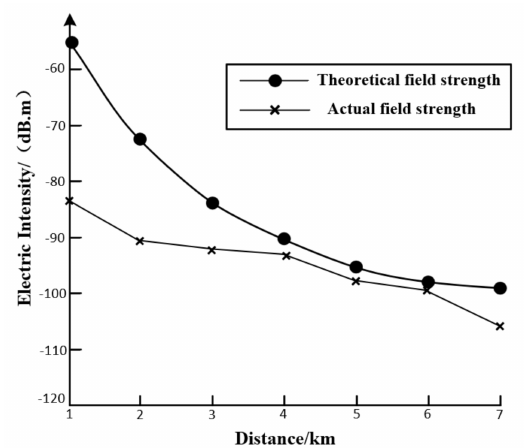
Figure 6. Comparison of the theoretical field strength and actual field strength of the Egli